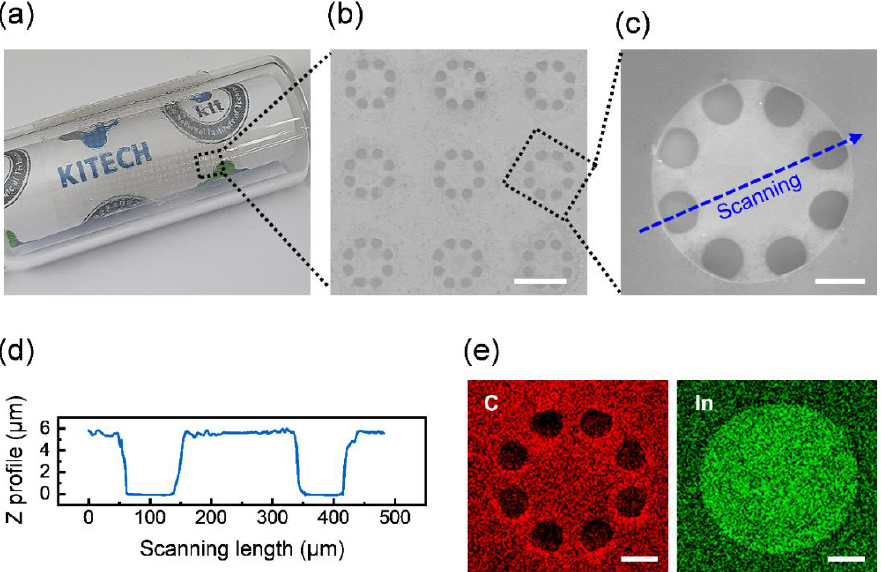
Figure 3. Configuration of the vibration sensor. ( a ) Photographic showing the transparency and flexibility of the vibration sensor. SEM image of ( b ) the diaphragm array (scale bar, 400 nm) and ( c ) a diaphragm structure of the vibration sensor (scale bar, 100 nm). ( d ) Height profile of cross-sectional view for the suspended diaphragm structure. Scanning route of ( d ) is shown in the dashed arrow of ( c ). ( e ) Carbon and indium elemental mapping data obtained using energy-dispersive X-ray mapping analysis for the same diaphragm in the SEM image ( c ) (scale bar, 100 nm).